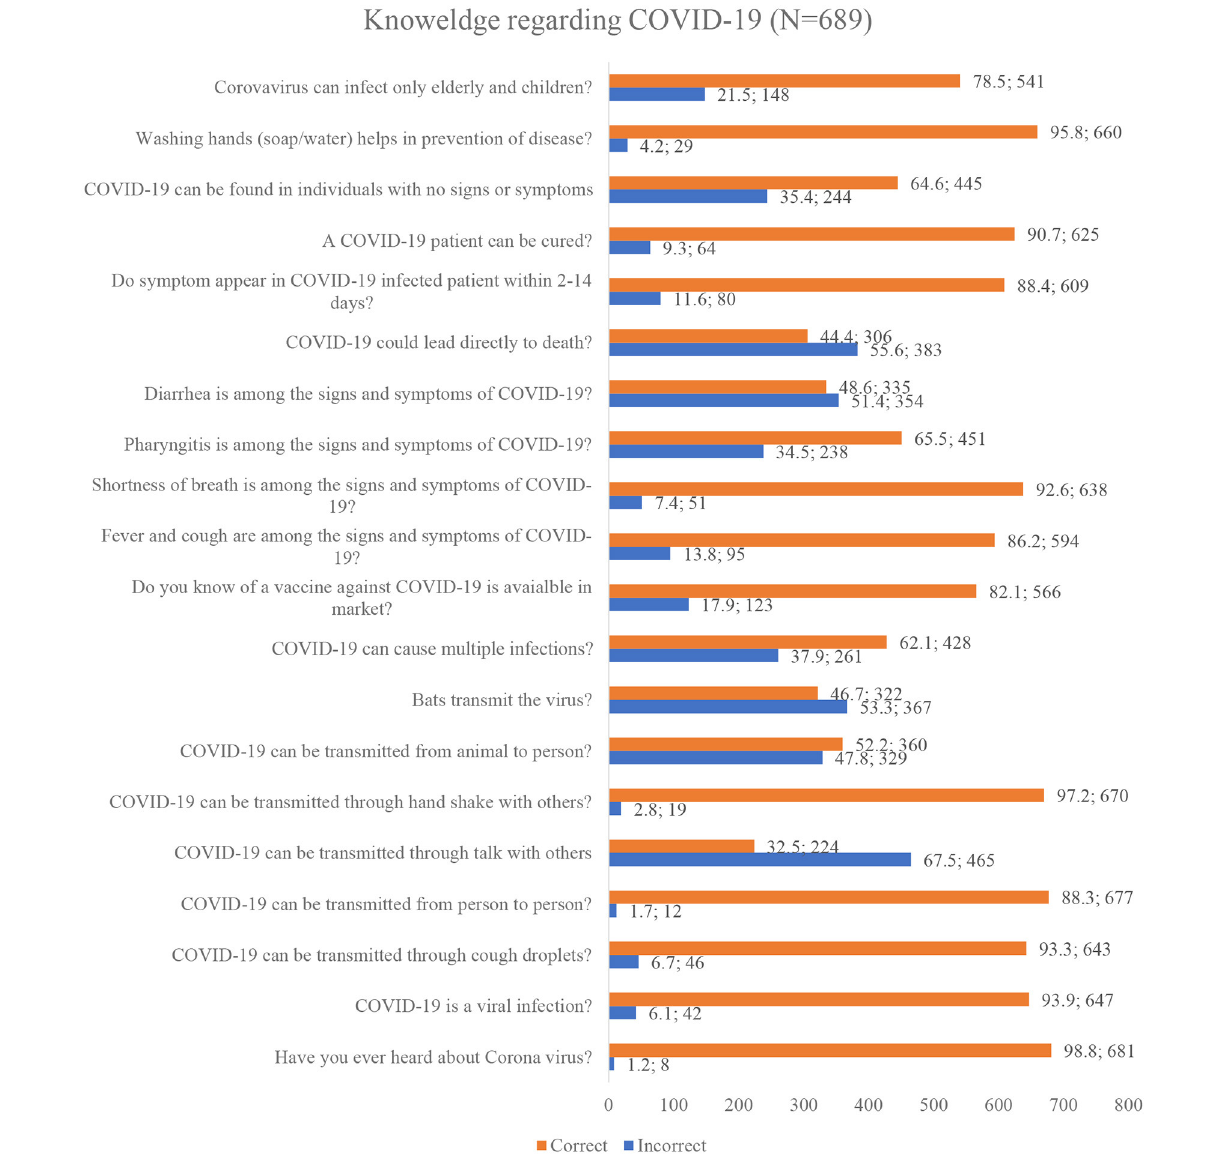
FIGURE 2 | Public’s Knowledge regarding